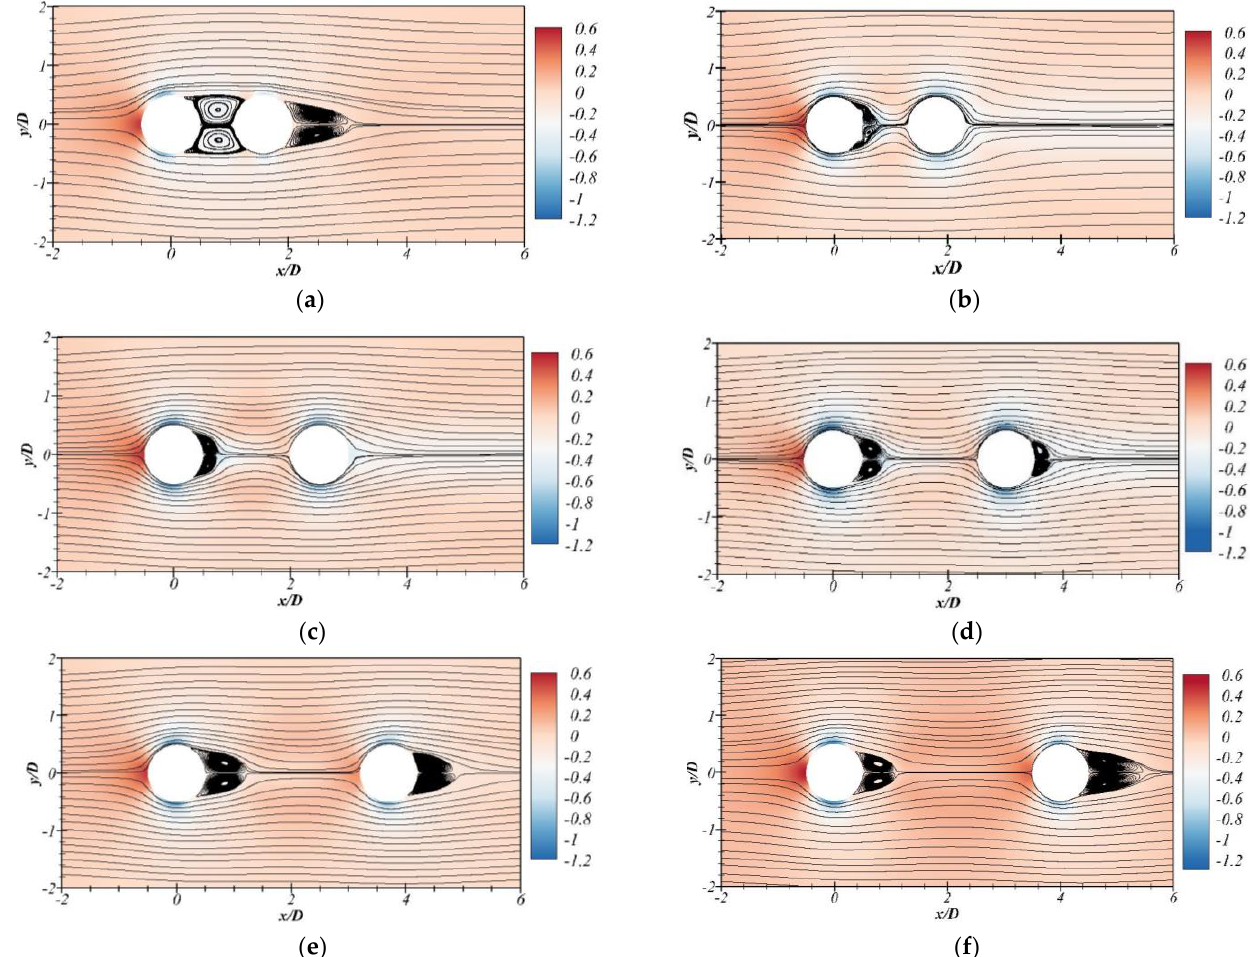
Figure 12. The time-averaged flow streamlines and pressure field for different distance ratios: ( a ) L / D = 1.56, ( b ) L / D = 1.8, ( c ) L / D = 2.5, ( d ) L / D = 3, ( e ) L / D = 3.7, ( f ) L / D = 4.